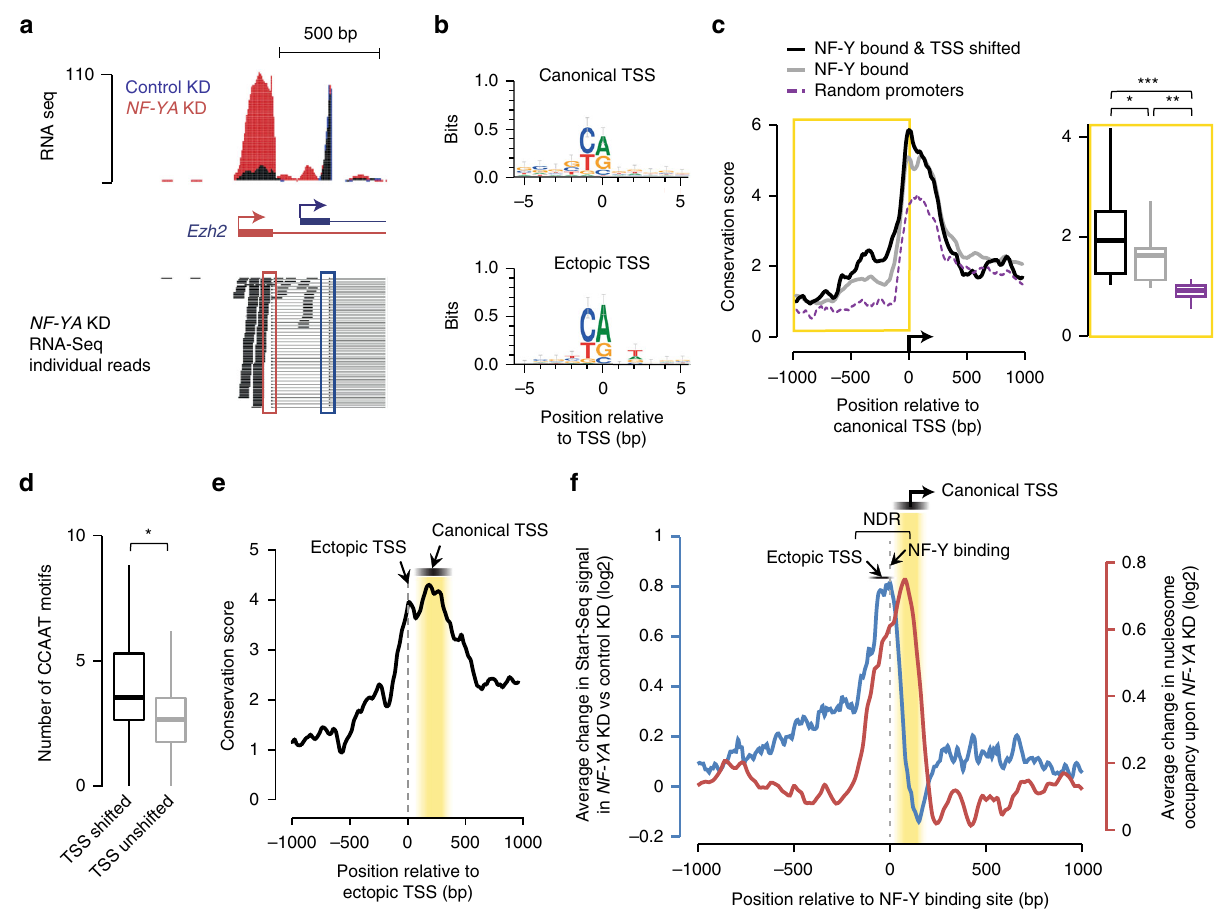
Fig. 3 Characterization of ectopic TSSs. a Genome browser shot of RNA-Seq signal at the Ezh2 gene showing an isoform switch in NF-YA KD (red) vs. control (blue) ESCs. A representative selection of individual RNA-Seq reads is shown beneath. Red and blue rectangles highlight the ectopic and endogenous splice sites, respectively. b Consensus sequence motif enriched within the 10 -bp region centered on canonical TSSs (top) or ectopic TSSs (bottom) of genes with promoter-proximal NF-Y binding, derived from de novo motif search. c Left: average sequence conservation in mammals, as computed using PhyloP 76 , of the 2-kb region centered on canonical TSS of genes with promoter-proximal NF-Y binding (gray, n = 3056), those that bind NF-Y and exhibit TSS shift (black, n = 538), or those chosen at random (purple, n = 538). Right: box plot showing PhyloP conservation score for the 1-kb region upstream of canonical TSS. * P -value = 0.01372, ** P -value = 1.69E-10, *** P -value = 3.77E-12 (Wilcoxon rank-sum test, two-sided). d Box plot showing the number of CCAAT motifs within 1-kb region upstream of canonical TSS for genes with promoter-proximal NF-Y binding that exhibit TSS shifts (black) or not (gray) in NF-YA KD ESCs. * P -value = 6.67E-36 (Wilcoxon rank-sum test, two-sided). e Average sequence conservation in mammals, as computed using PhyloP 76 , of the 2-kb region centered on ectopic TSS of genes with promoter-proximal NF-Y binding that exhibit an ectopic TSS ( n = 538). f Average fold change (log2; primary y -axis) in Start-Seq signal (blue) in NF-YA KD vs. control KD ESCs near TSSs of NF-Y-bound genes exhibiting TSS shifts (red). Also shown is the average fold change (log2; secondary y -axis) in nucleosome occupancy (red) in NF-YA KD vs. control KD ESCs.